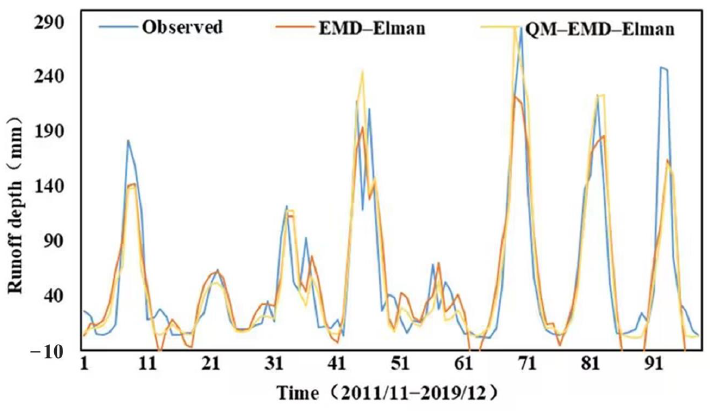
Figure 10. Prediction series of monthly runoff, using on the triple-coupled model under the quantile mapping method. Table 4. Evaluation of triple-coupled model’s monthly runoff predictions during the validation period.